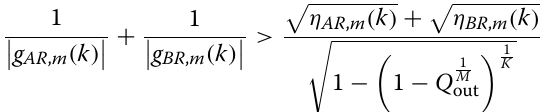
Algorithm 2: Joint implementation of relay selection, power adaptation and bit-rate